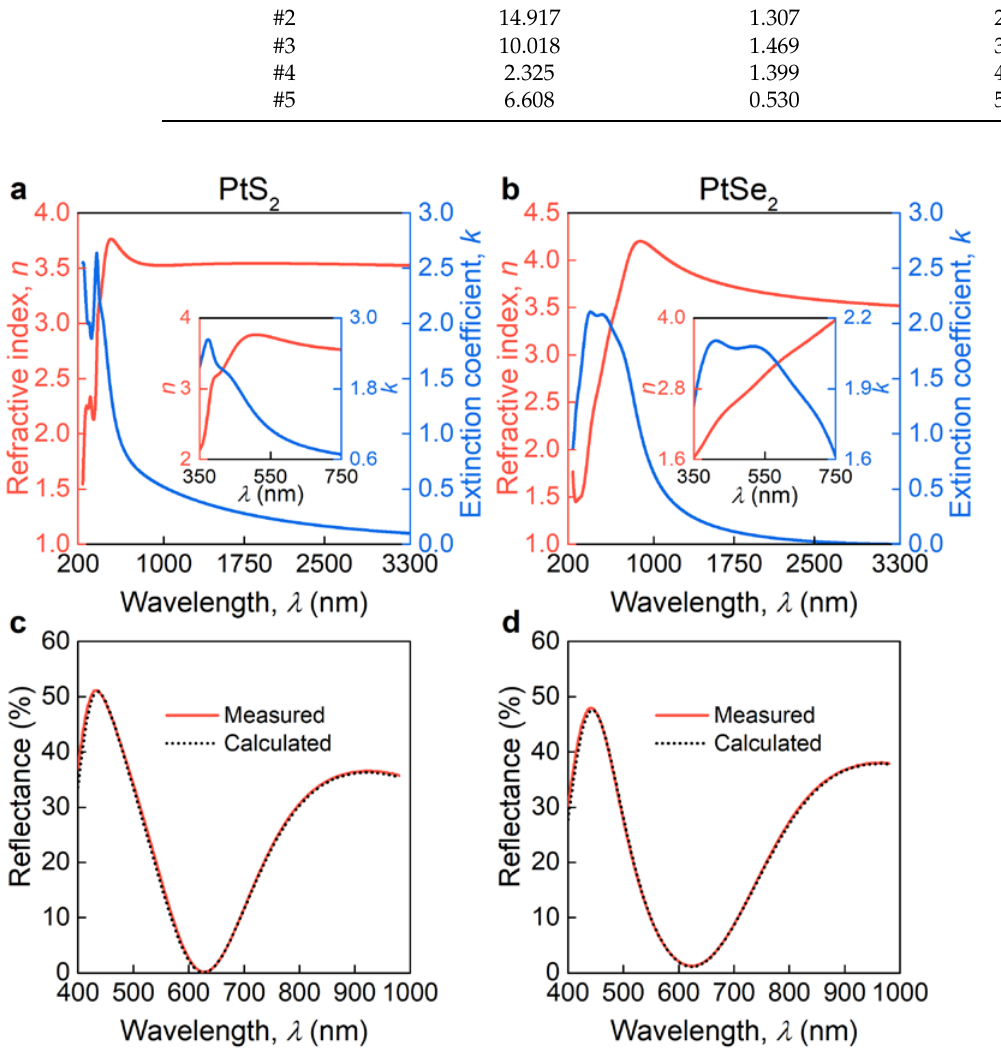
Figure 3. Optical properties of PtS 2 and PtSe 2 . Optical constants of ( a ) PtS 2 and ( b ) PtSe 2 . The insets show PtS 2 and PtSe 2 optical constants in the visible range. Measured and calculated reflectance spectra for ( c ) PtS 2 and ( d ) PtSe 2 on SiO 2 /Si substrate.